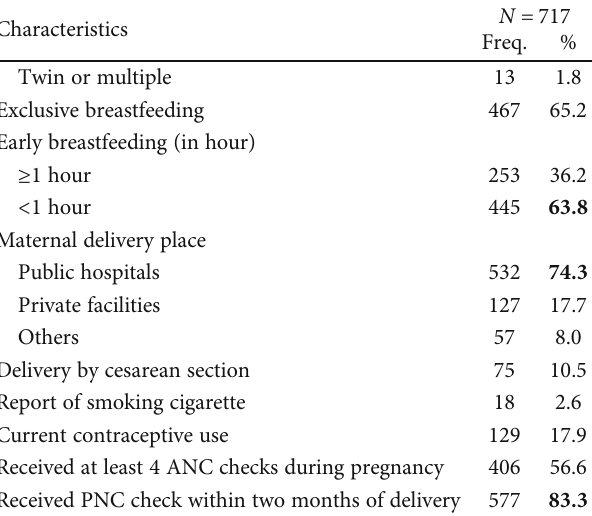
Table 1: Sociodemographic characteristics and maternal healthcare access and